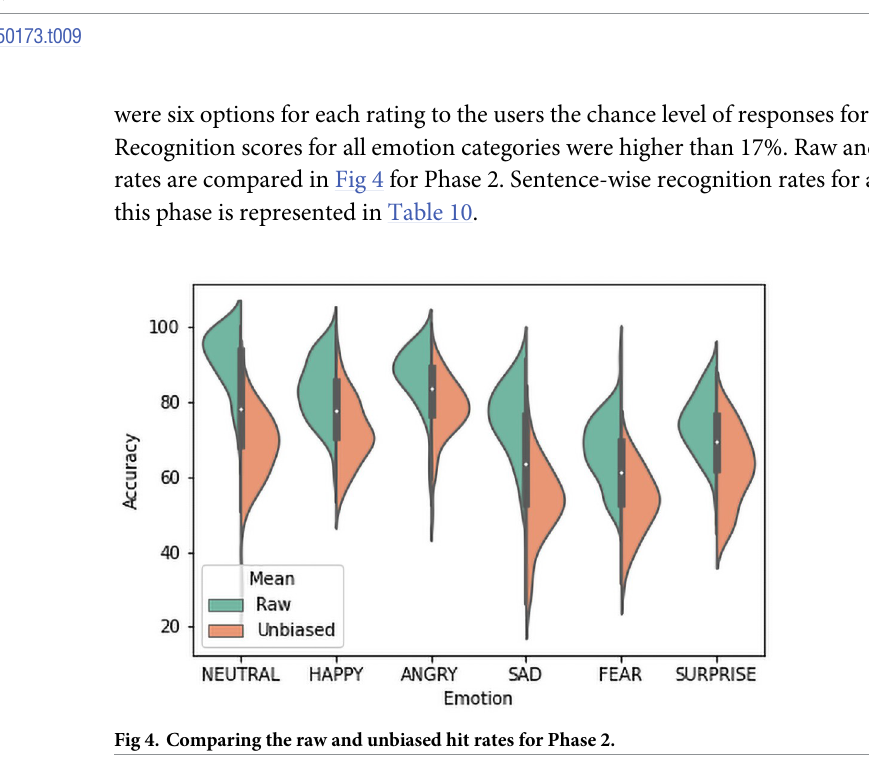
Fig 4. Comparing the raw and unbiased hit rates for Phase 2.